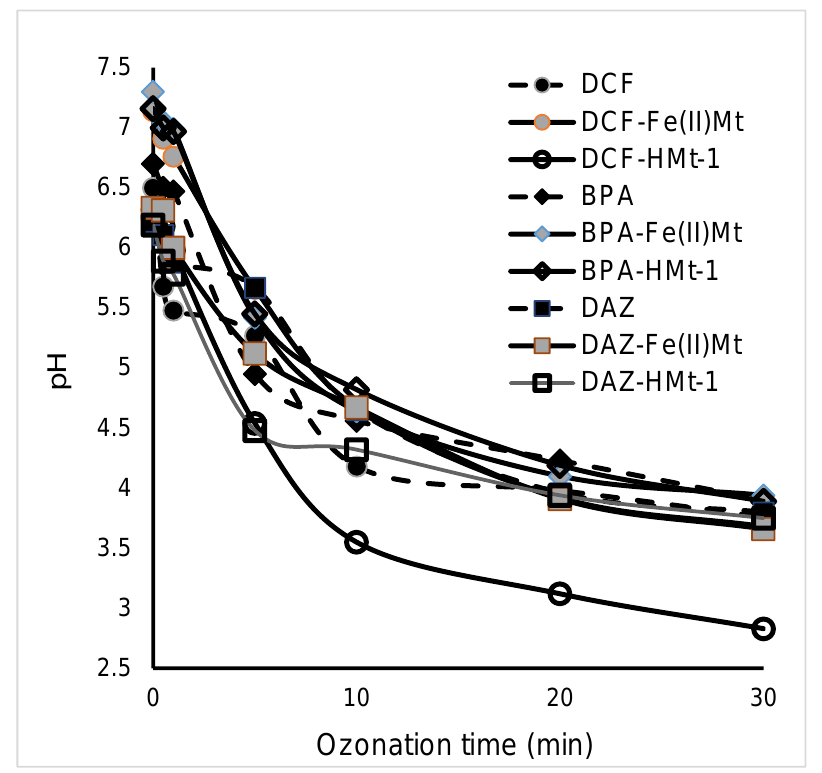
Figure 7. pH evolution during ozonation in the presence of Fe(II)Mt and HMt-1 at room temperature. V = 30 mL, Ozone throughput = 600 mg h −1 ; Initial concentration of organic substrate = 30 mg g −1 ; Catalyst amount: 40 mg.